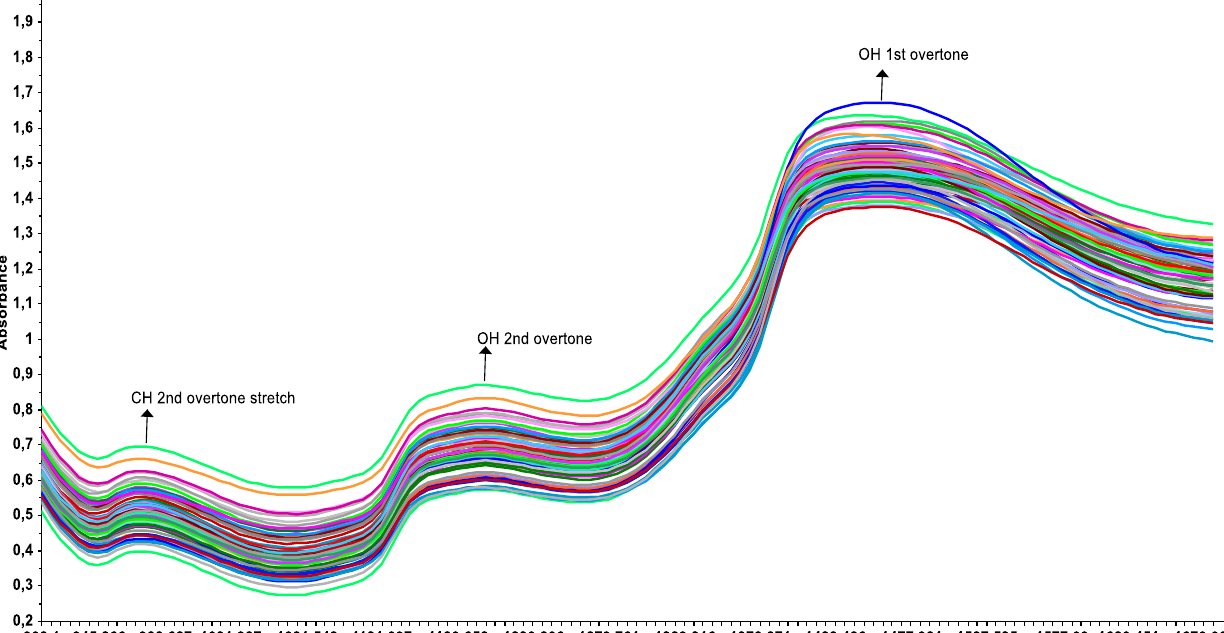
Figure 1. The NIR spectra of the chili samples, between 908–1676 nm were obtained using the handheld microNIR probe.